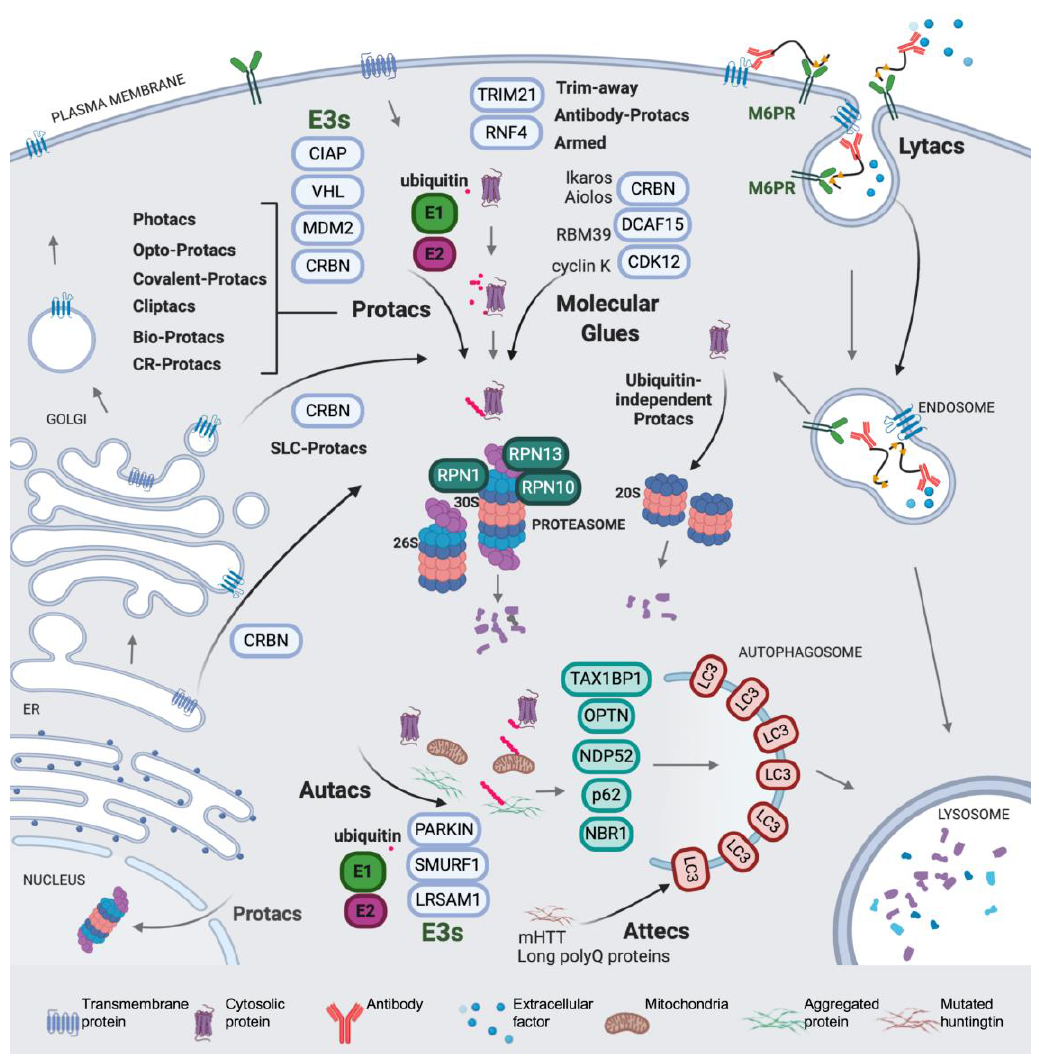
Figure 1. Schematic representation of the main routes of TPD in the cell. Degradation pathways targeting cargos to the proteasome and to the lysosome are shown. Curved arrows indicate the action of degrader molecules, including distinct types of protacs, molecular glues, lytacs, autacs and attecs, as they are described in the literature. Protacs and molecular glues utilize the E3 ligases shown (blue ovals), directing to the 26S and 30S proteasomes the ubiquitinated targets, which are recruited by means of the Rpn1, Rpn10 and Rpn13 proteasome receptors (dark green ovals). Ubiquitin-independent protacs direct targets to the 20S protesome. Lytacs utilize the M6PR (green) receptor to internalize external proteins to pre-lysosomal compartments, and finally deliver them to the lysosome. Autacs require E3 ligases, such as Parkin, Smurf1 and Lrsam1 (blue ovals), to target ubiquitinated cargo to autophagy receptors (OPTN, NDP53, p62, NBR1 and TAX1BP1) (green ovals), which interact with LC3 to induce cargo engulfment and autophagosome formation. On the other hand, attecs directly link protein targets with LC3, promoting engulfment and autophagosome formation. Autophagosomes are eventually integrated to the lysosome, which will hydrolyze the incoming materials. For abbreviations, see main text. Ubiquitination is catalyzed by the sequential activity of ubiquitin-activating (E1), ubiquitin-conjugating (E2), and ubiquitin ligases (E3) enzymes, which promote the formation of ubiquitin-protein